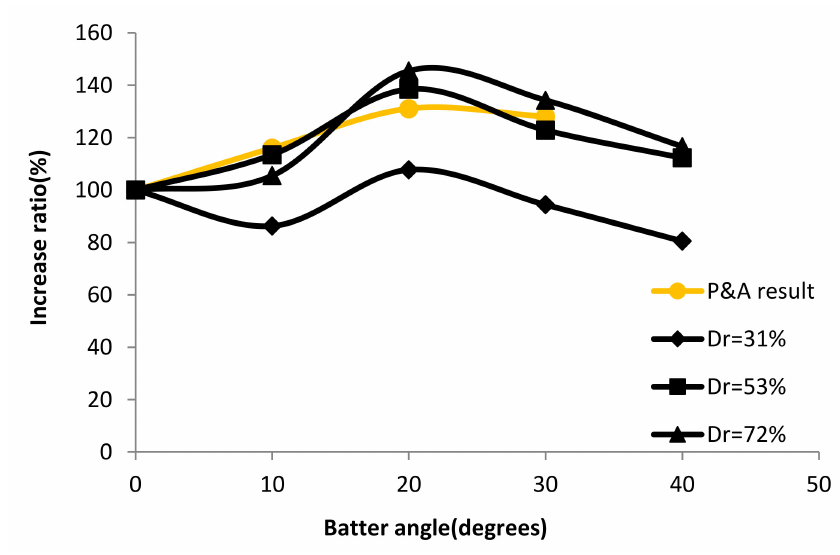
Figure 14. Comparisons between the test results and a previous